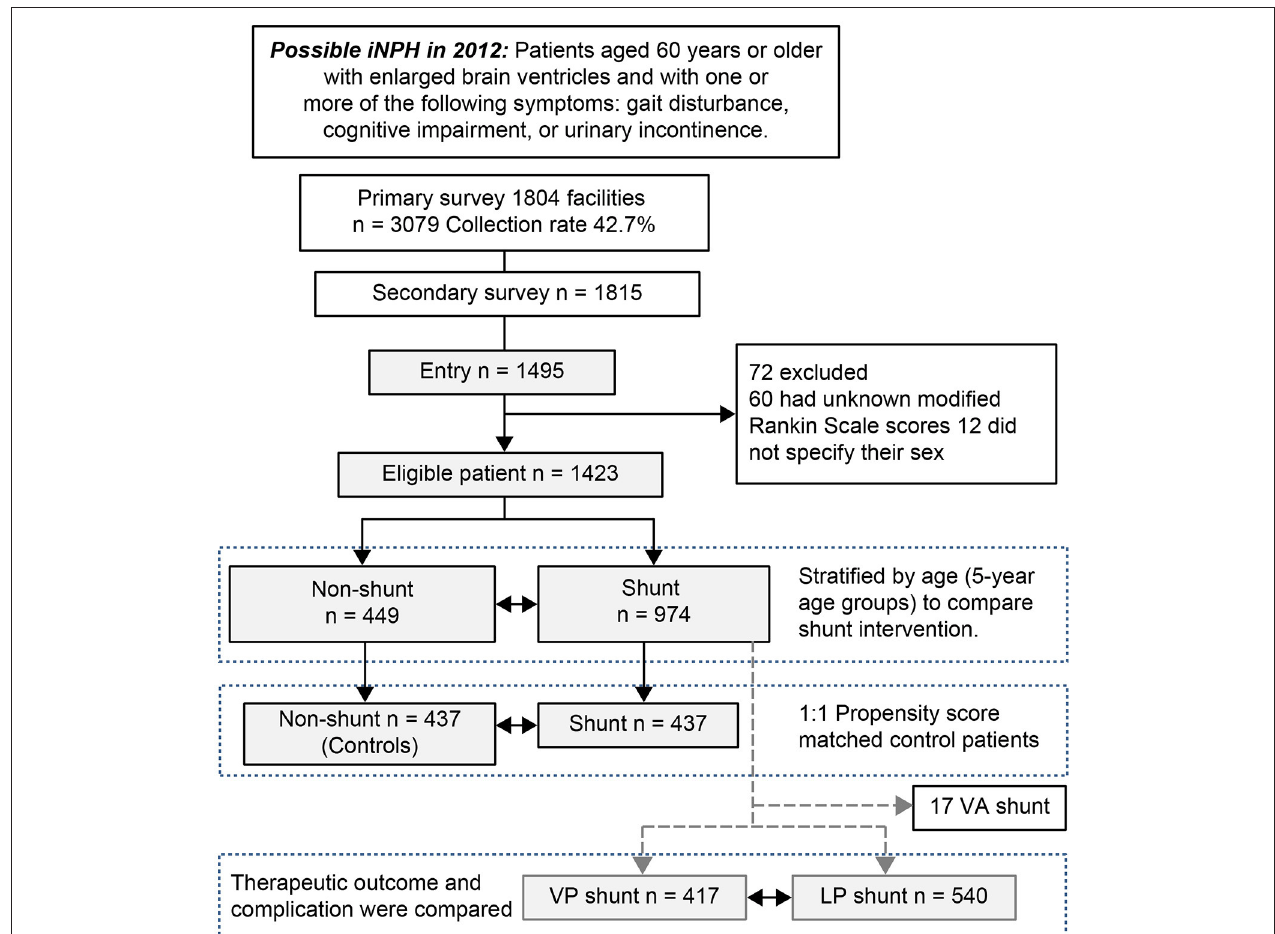
FIGURE 1 | Flow diagram for enrollment of patients with possible idiopathic normal pressure hydrocephalus. Patients with idiopathic normal pressure hydrocephalus (iNPH) who underwent shunt intervention were matched to patients who did not undergo shunt intervention using 1:1 propensity score matching. Confounding factors affecting intervention outcome in the secondary survey were tabulated using cross tabulation and analyzed using a binomial logistic regression analysis and Wald chi-squared test for the propensity score. Finally, we examined subjects in the shunt intervention group to compare the outcomes and complications of ventriculoperitoneal (VP) shunts and lumboperitoneal (LP) shunts. VA, ventriculoatrial.